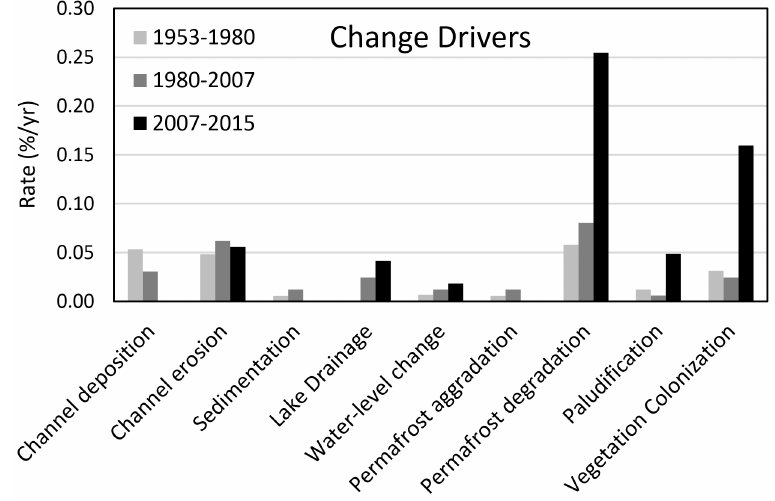
Figure 9. Areal extent of change based on the type of change evident on imagery from ~1953, 1980, ~2007 and ~2015 along the central coast of the Yukon-Kuskokwim Delta.